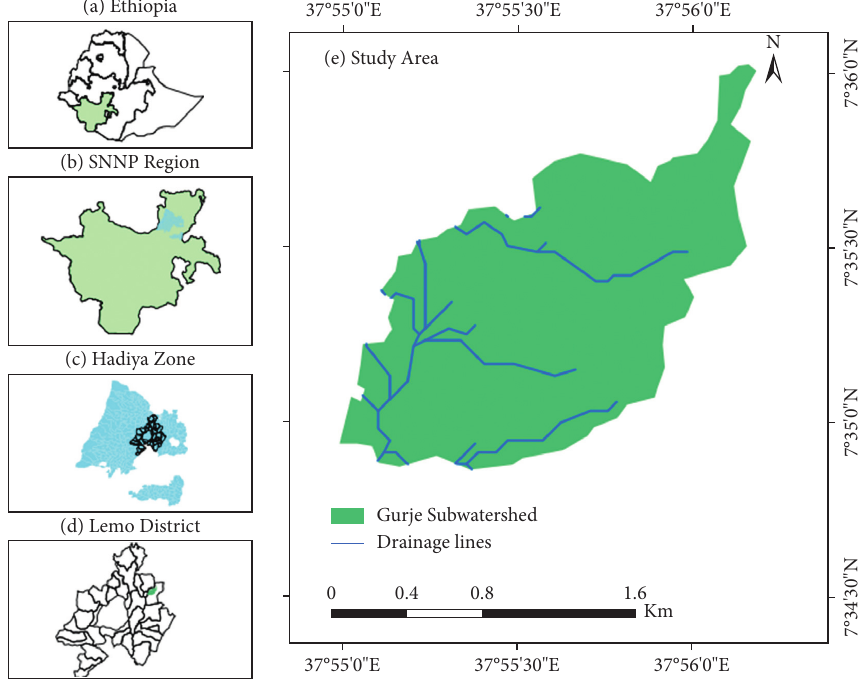
Figure 1: Map of the study area. (a) Ethiopia. (b) SNNP region. (c) Hadiya zone. (d) Lemo district. (e) Study area.